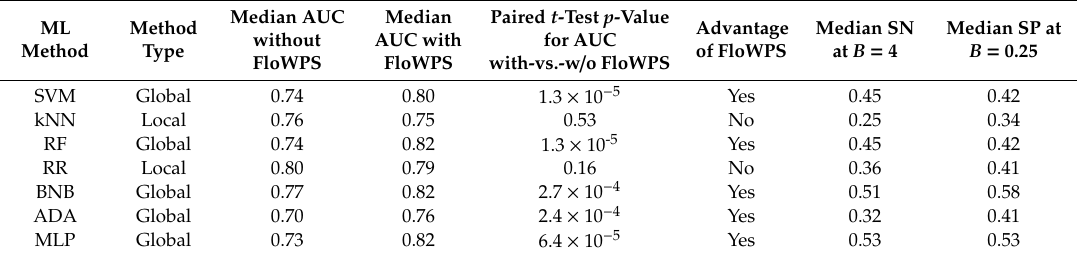
Table 1. Performance metrics for seven ML methods with default settings for datasets with equal numbers of responders and non-responders.